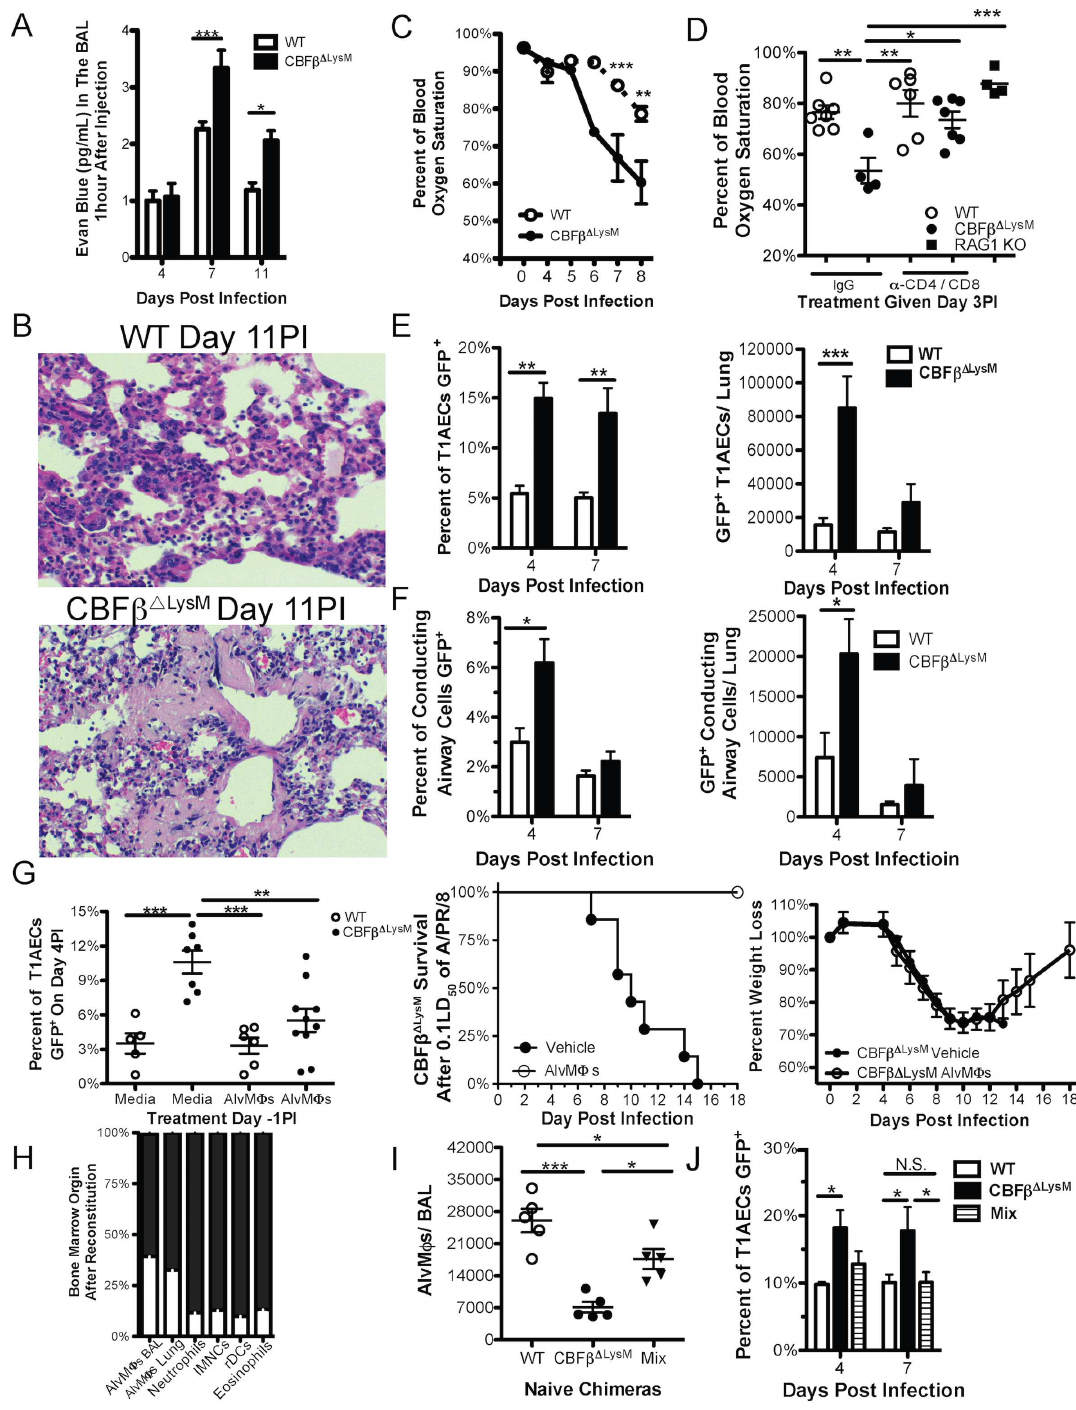
Fig 3. AlvM Φ sregulate the susceptibility of type 1 alveolar epithelial cells to IAV infection. WT and CBF β Δ LysM mice were infected i.n. with a 0.1LD50dose of a-c) 0.1LD50of A/PR/8 or d-g) NS1-GFP A/PR/8. a) At the indicateddays PI Evans Blue dye leak into the airspacewas quantified.b) Representative H&E section images from day 12 PI IAV infected WT and CBF β Δ LysM . c) Percent blood oxygen saturation at the indicateddays PI. d) Day 7 PI blood oxygen saturation after i.p. injection of CD4 and CD8 depletingantibodiesat day 3 PI. Percent of (left) and total numbersof (right) infected e) T1AECs and f) conductingairway epithelialcells at day 4 & 7 PI. g) AlvM Φ swere transferred i.n. at day -1PI and (left) the percent of T1AECs that were infected at day 4PI was determined, as well as, (right) CBF β Δ LysM survival out to day 20PI (n = 4 CBF β Δ LysM